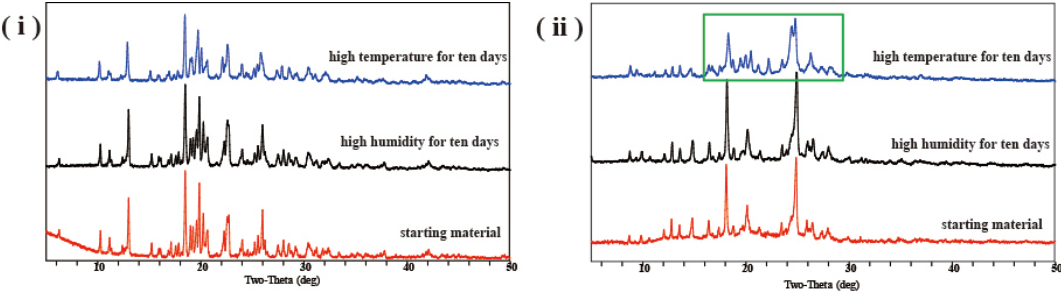
Figure 8. Results of stability testing of ARI-SAL salt ( i ) and ARI-ADI salt acetone hemisolvate ( ii ).